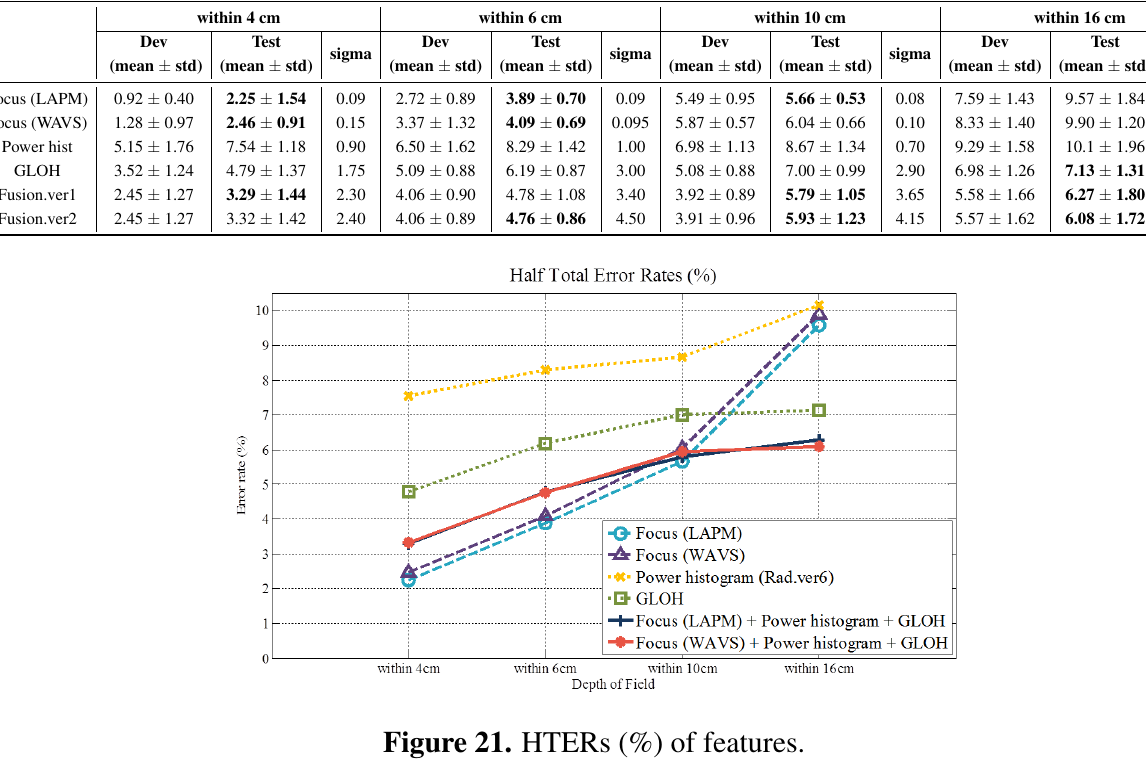
Table 3. Half total error rates (HTERs) (%) of the experiments with the mirrorless camera database.